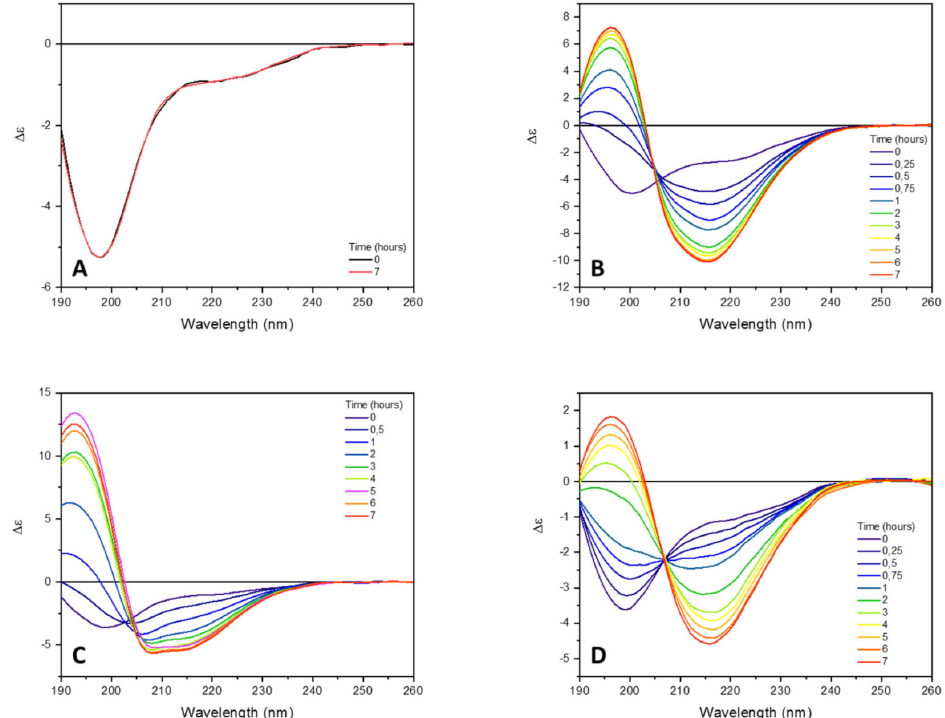
Figure 2. Far-UV SRCD spectra of tau peptide (70.9 µ M) in 10 mM TRIS-HCl buffer, pH 7.4. ( A ) Alone; ( B ) in presence of 0.25 equivalents of low-molecular-weight heparin; ( C ) in presence of 0.25 equiva- lents heparin and 6 equivalents of trehalose; ( D ) in presence of 0.25 equivalents of heparin and 6